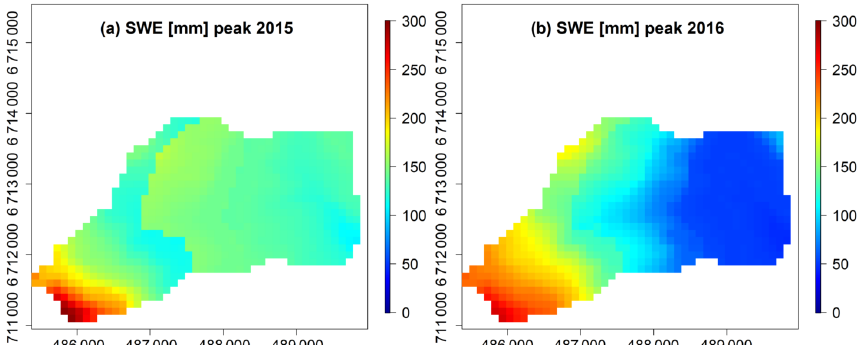
Figure 5. Spatial distribution of snow water equivalent SWE (mm) for the day of peak SWE in both study years: (a) 23 February 2015 and (b) 19 March 2016.